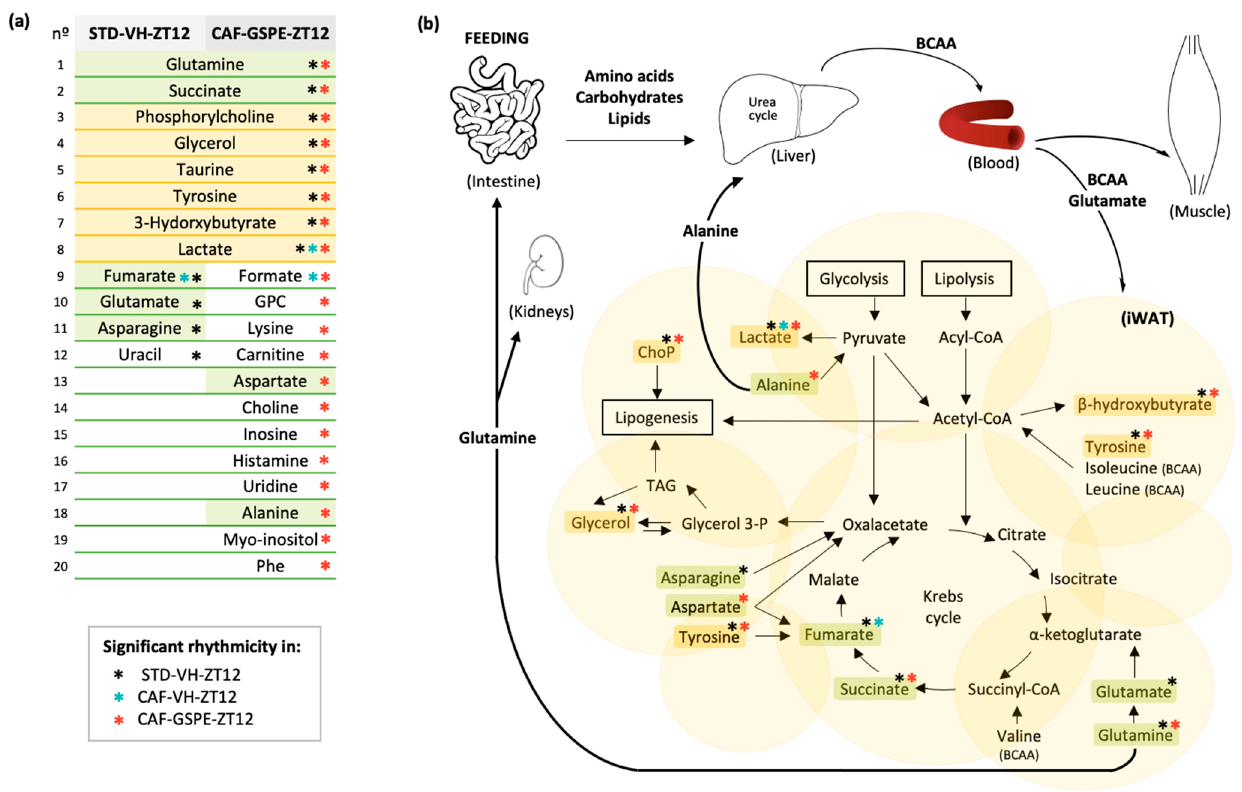
Figure 4. Metabolic network analysis of identified rhythmic metabolites in iWAT. Hydrophilic metabolites with diurnal rhythm in the corresponding groups, ( a ) inter-tissue amino acid flux and alanine, aspartate, and glutamate metabolism pathway ( b ). Green boxes indicate metabolites involved in alanine, aspartate, and glutamate metabolism that are rhythmic in STD-VH-ZT12, CAF-GSPE- ZT12, or both groups; yellow boxes indicate metabolites that are rhythmic in both STD-VH-ZT12